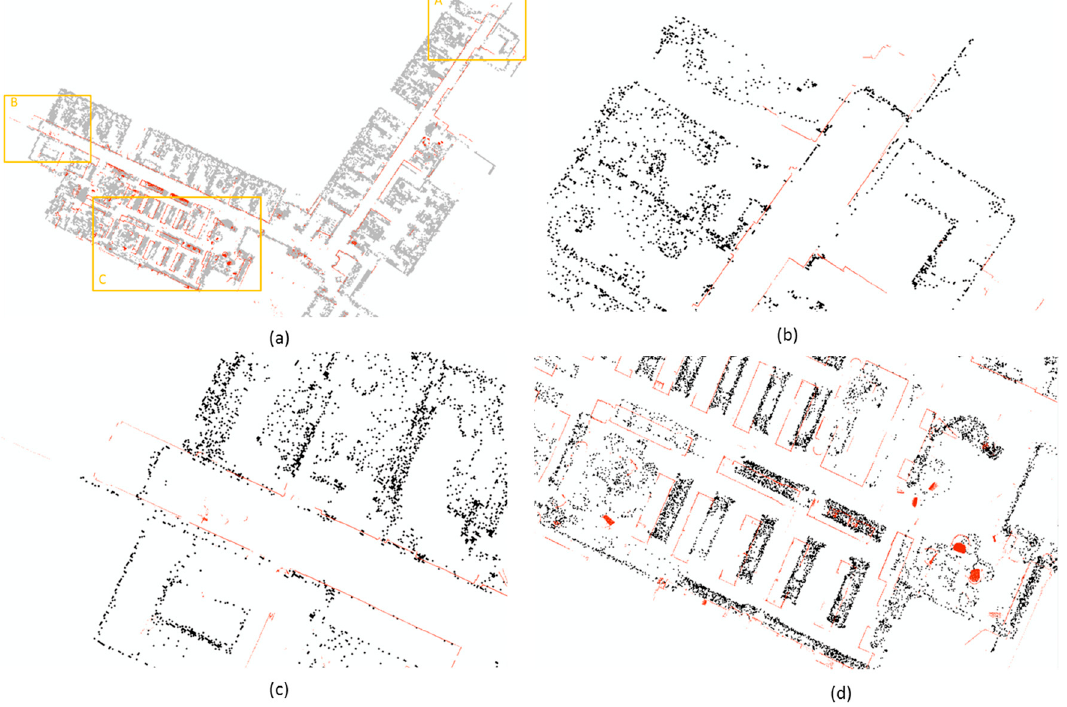
Figure 7. Mapping results comparison between T1 with TLS reference, where TLS reference is illustrated in red color against the black point cloud collected by Matterport ( a ) an overview comparison, ( b ) details at the end of east wing, ( c ) details at the end of south wing, ( d ) details of the open library in south wing.